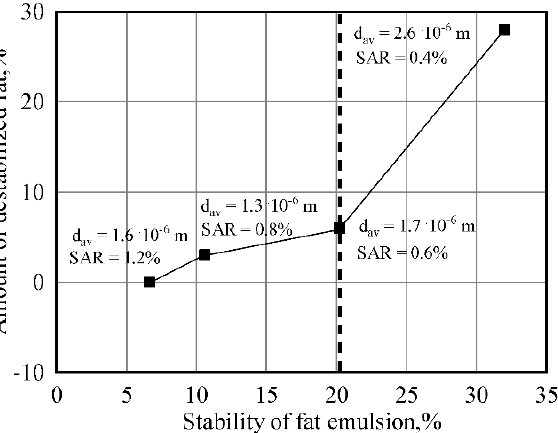
Figure 8. Variations in the degree of dispersion and fat emulsion stability as a function of surfactant concentration (concentration of surfactant, %: monoglyceride + lecithin in the ratio of 3:1; τ = 1.5 min.).